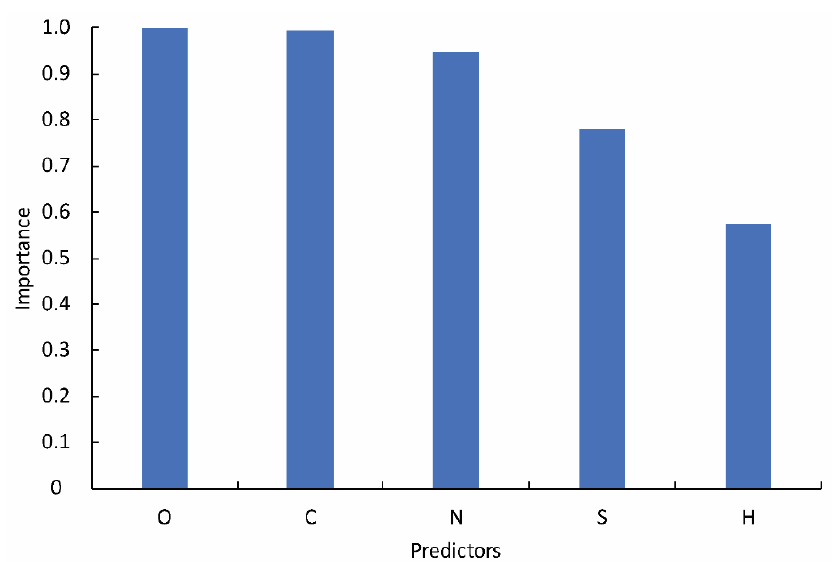
Figure 3. Importance of predictors (ultimate analysis) on HHV (RFR model).